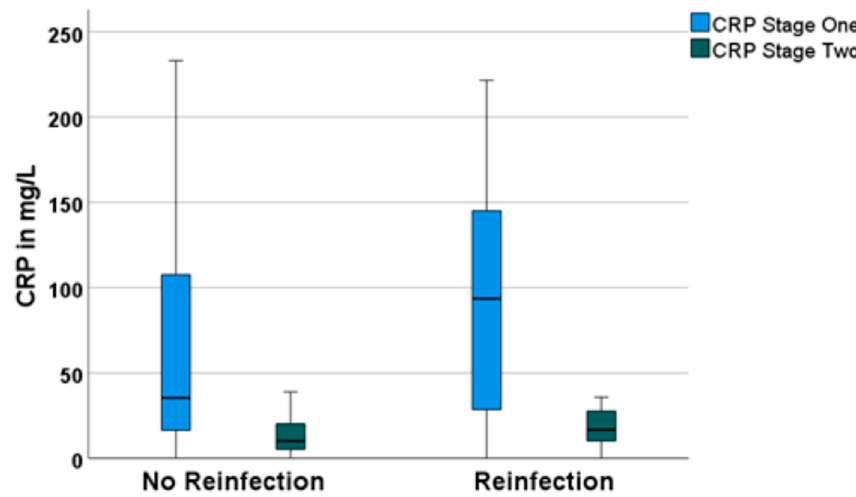
Figure 1. Boxplots for C-reactive protein (CRP) values of the first stage of TSR and the second stage of TSR, grouped according to “no reinfection” and “reinfection”.